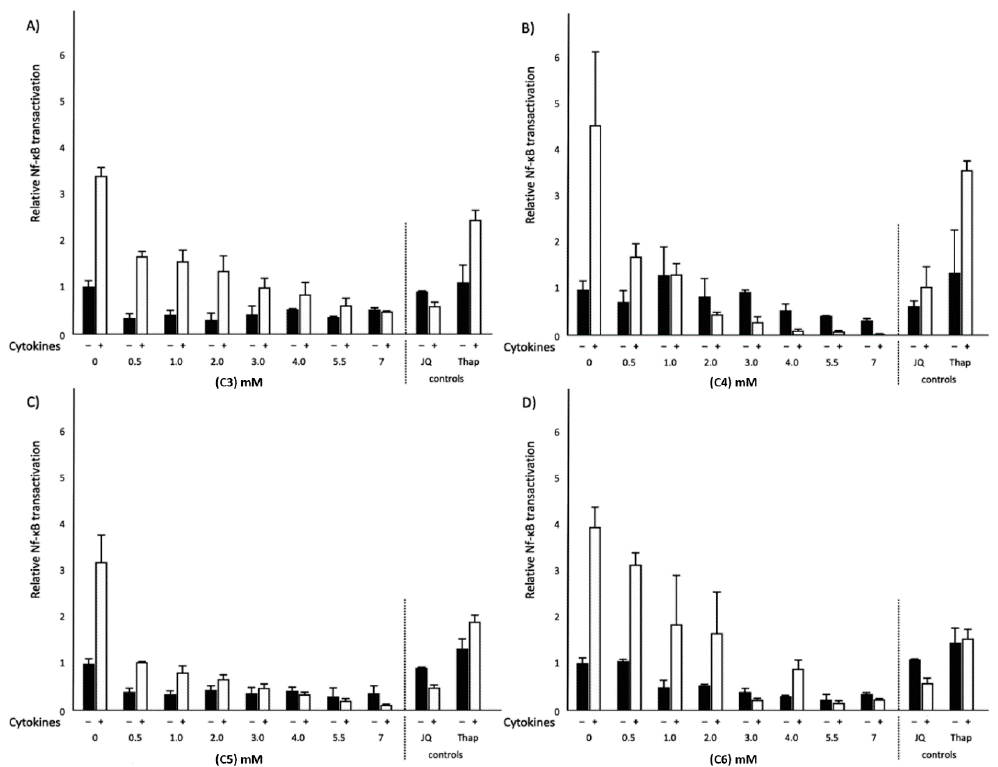
Figure 3. Relative nuclear factor kappa b (NF ‐κ B) transactivation in HepG2 cells treated with different